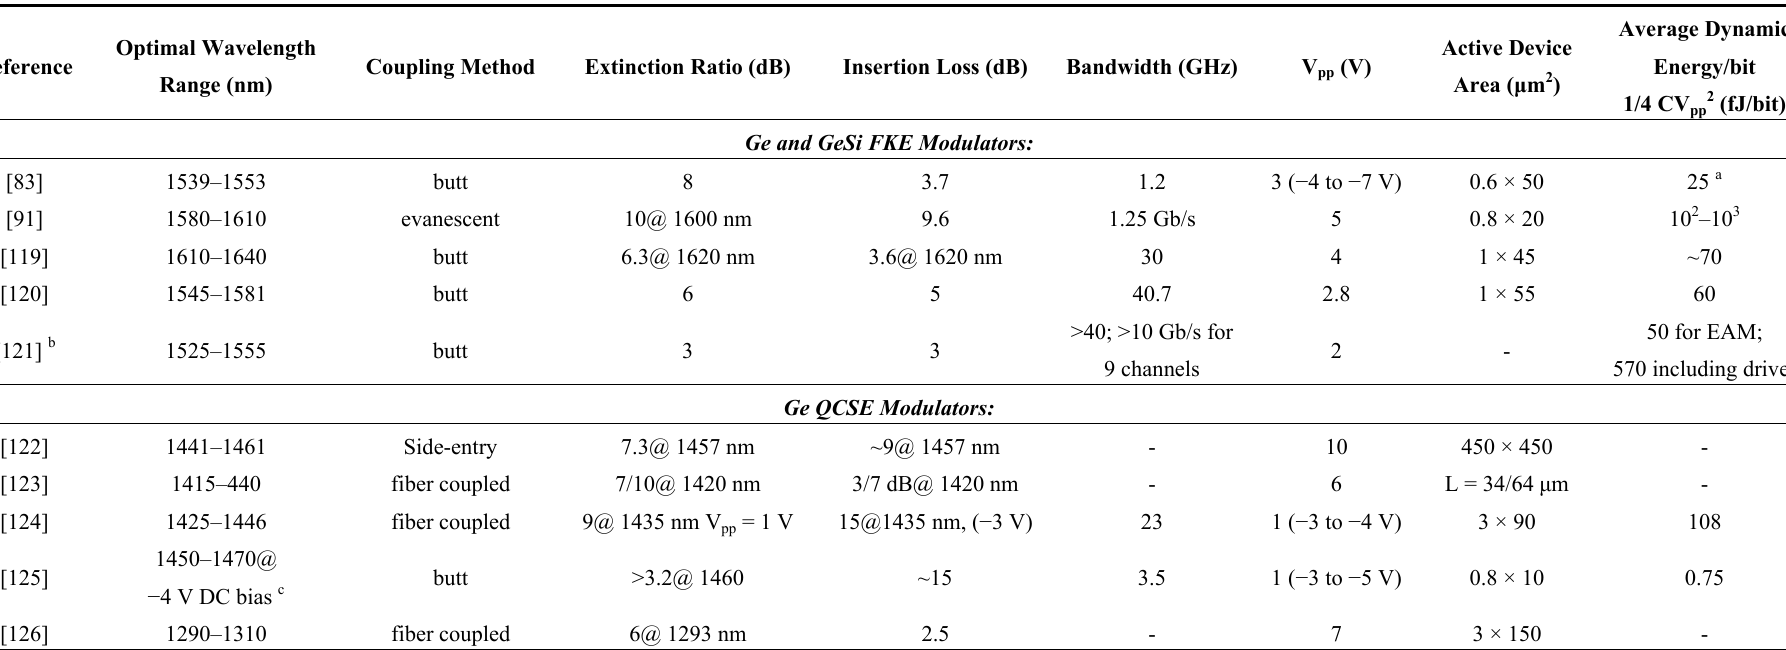
Table 2. Summary of Ge and GeSi EAM performance. The data are reported for 1550 nm operation, and the voltage swing is from 0 to − V (reverse bias) unless otherwise